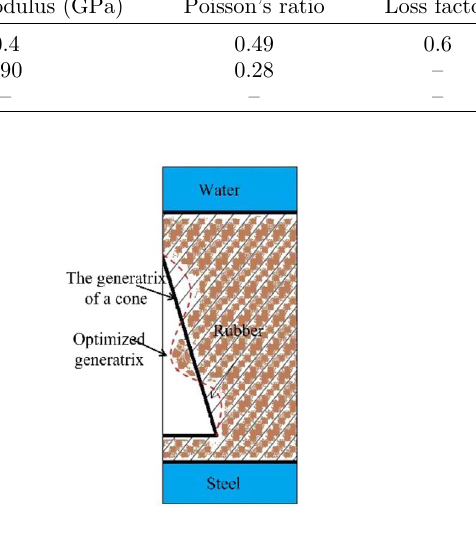
Figure 3. Schematic diagram of the anechoic internal cavity. Table 2. Constraints of 10 optimization